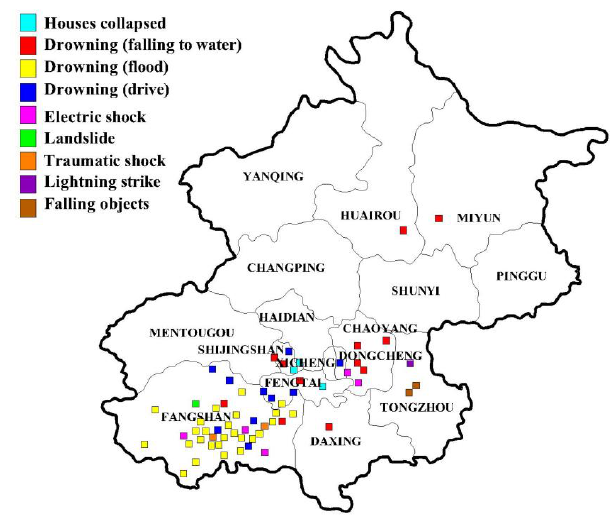
Fig. 4. Distribution of victims in the extreme rainfall event